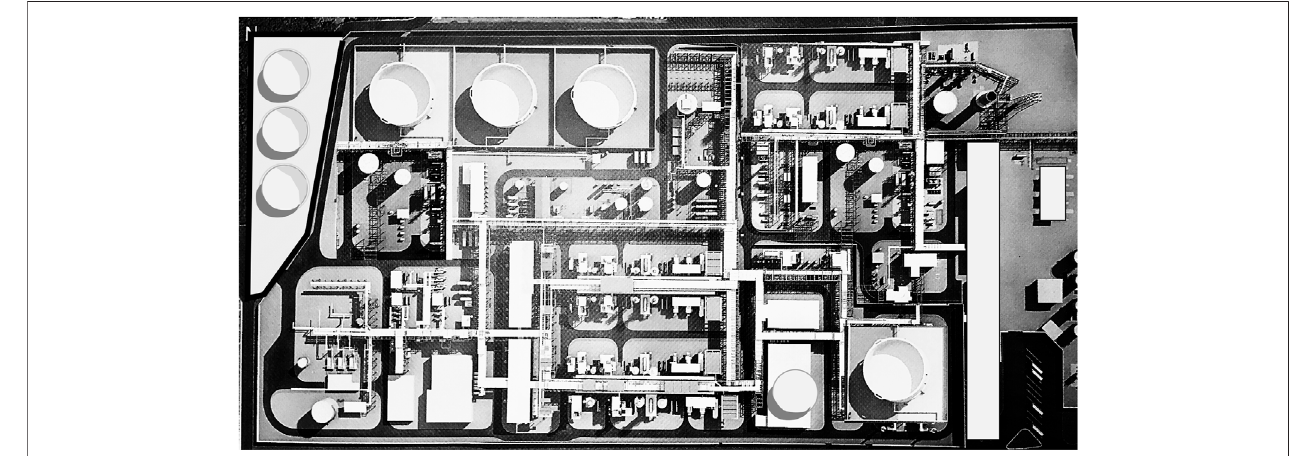
FIGURE 6 | Plan view of the case study.